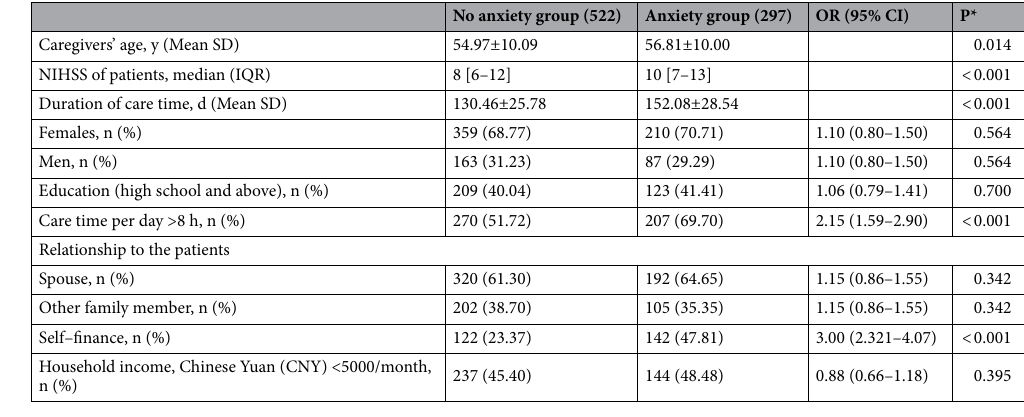
Table 1. Comparison of baseline characteristics between caregivers with no anxiety and anxiety groups.